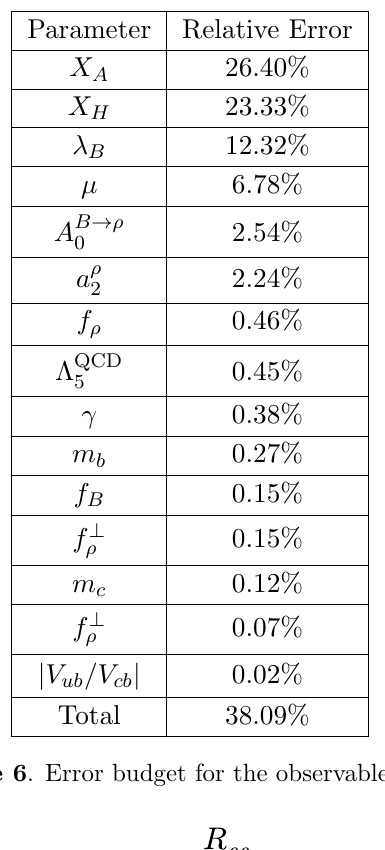
( M W ) allowed by the observable 1 ( M W ) are very weak and hence not shown. The black 2